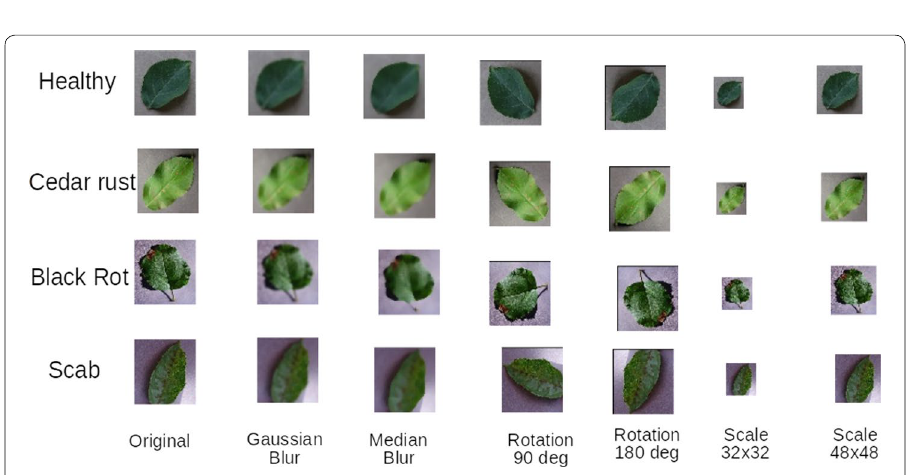
Fig. 11 Samples of apple test images: original and after various